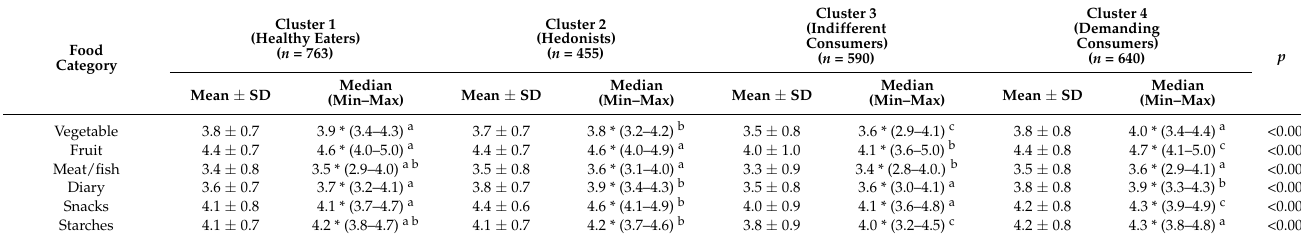
Table 2. The food preferences were assessed by using the Food Preference Questionnaire (FPQ) for subgroups stratified based on the clustering of the scores assessed while using the Food Choice Questionnaire (FCQ) within the population of the second phase of the Polish Adolescents’ COVID-19 Experience (PLACE-19) Study ( n = 2448). Cluster1 (HealthyEaters) Food ( n =763) Category